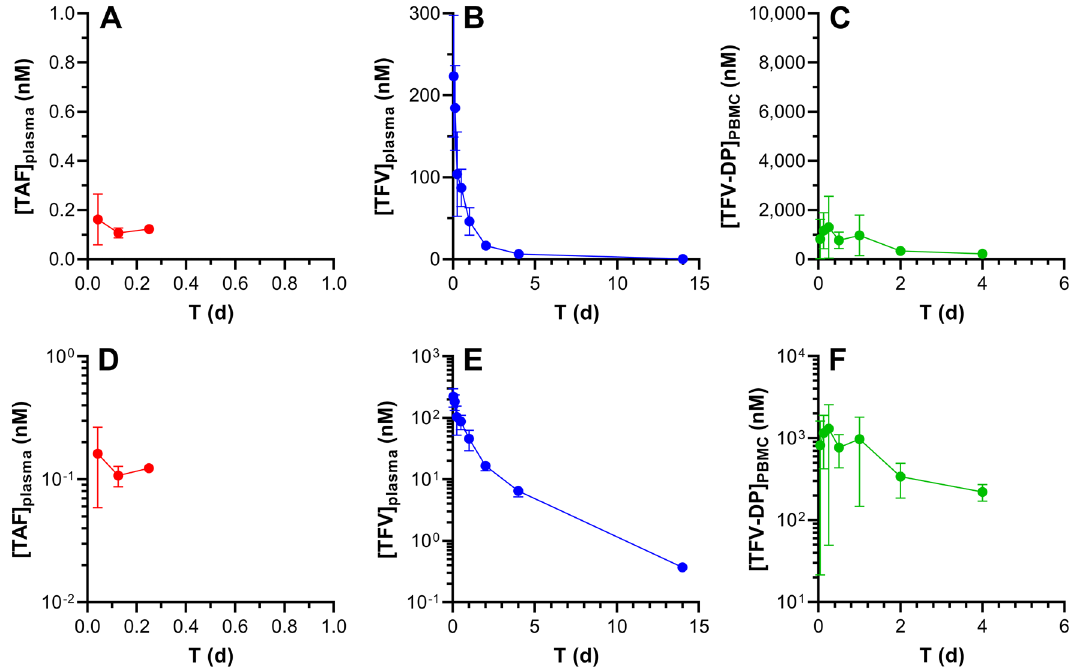
Figure 2. Intravenous TAF injection in C57BL/6 J mice results in different pharmacokinetics across the three key analytes. The data are shown as linear ( A – C ) and semilog ( D – F ) plots and all concentration units are represented in nanomolar (nM) for ease of comparison. Concentration–time profiles of plasma TAF ( A and D ; red circles), plasma TFV ( B and E ; blue circles), and PMBC TFV-DP ( C and F ; green circles) are shown as means ± SD ( N = 4 per group). The assay lower limits of quantitation (LLQs) are: TAF, 0.06 nM (0.03 ng mL -1 ); TFV, 3.5 nM (1 ng mL -1 ); TFV-DP, 18 nM (based on 5 fmol/sample, and a median of 1.4 × 10 6 PBMCs per